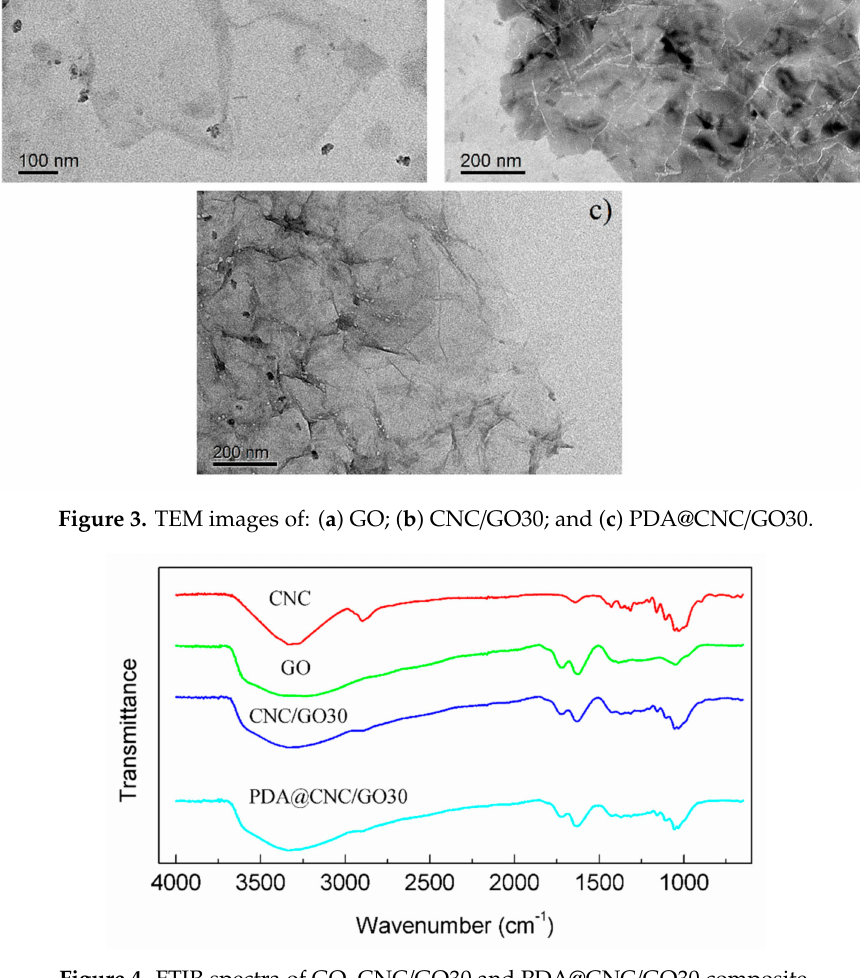
Figure 4. FTIR spectra of GO, CNC / GO30 and PDA@CNC / GO30